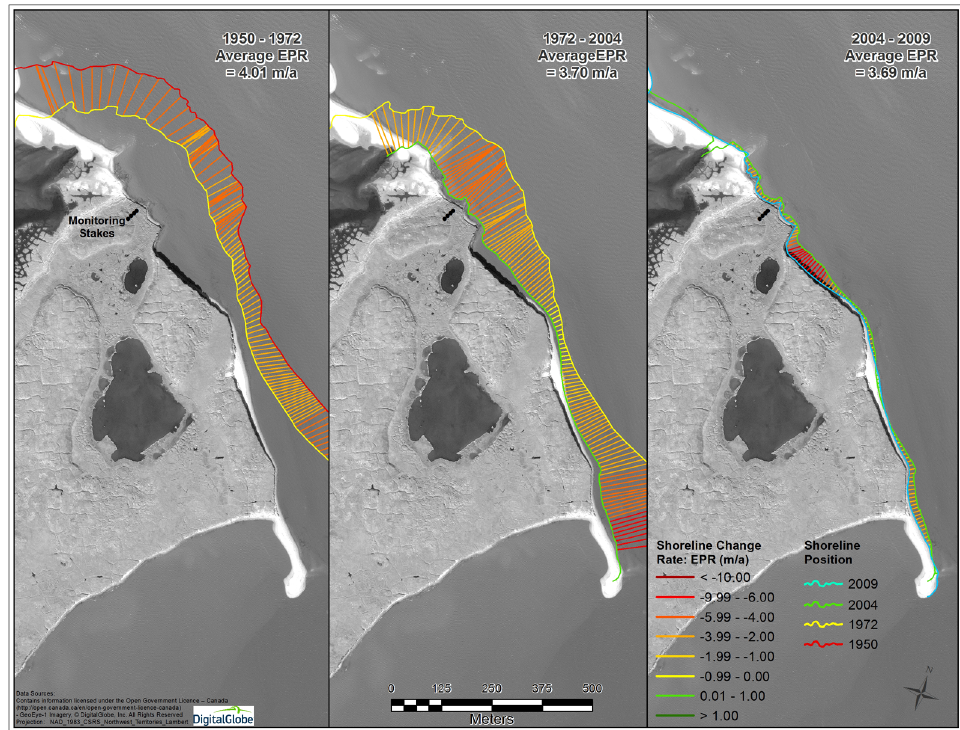
Fig. 9: End Point Rate (EPR) shoreline change calculations for three individual time periods at east Toker Point.